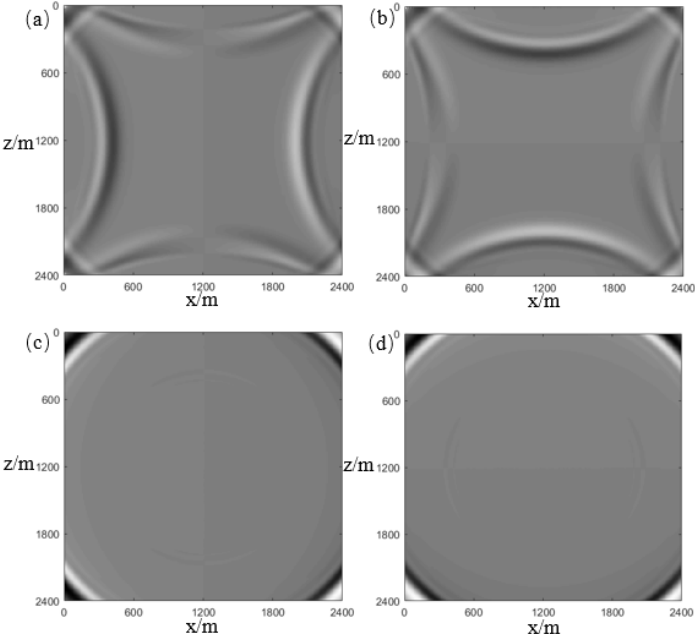
Figure 5. Wave field computed by GFDM, ( a ) X component (without attenuation boundary); ( b ) Z component (without attenuation boundary); ( c ) X component (45 layers of Cerjan boundary); ( d ) Z component (45 layers of Cerjan boundary).